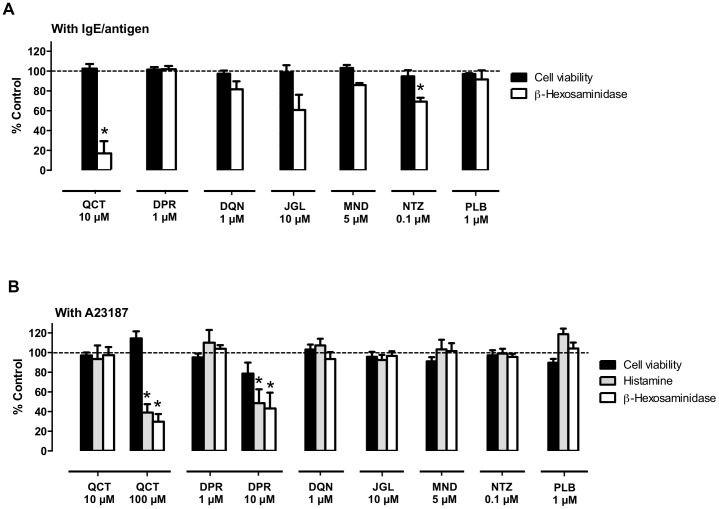
RBL-2H3 cells' degranulation inhibition by naphthoquinones.Effect on cell viability and β-hexosaminidase and histamine release in (A) IgE-antigen- or in (B) calcium ionophore (A23187)-stimulated cells treated with quercetin (QCT) and naphthoquinones [diospyrin (DPR), diosquinone (DQN), juglone (JGL), menadione (MND), naphthazarin (NTZ) and plumbagin (PLB)], n = 3–10. *P<0.05, paired t test to respective control (100 ng/mL IgE/DNP + 0.1% DMSO or 1 µM A23187 + 0.5% DMSO).